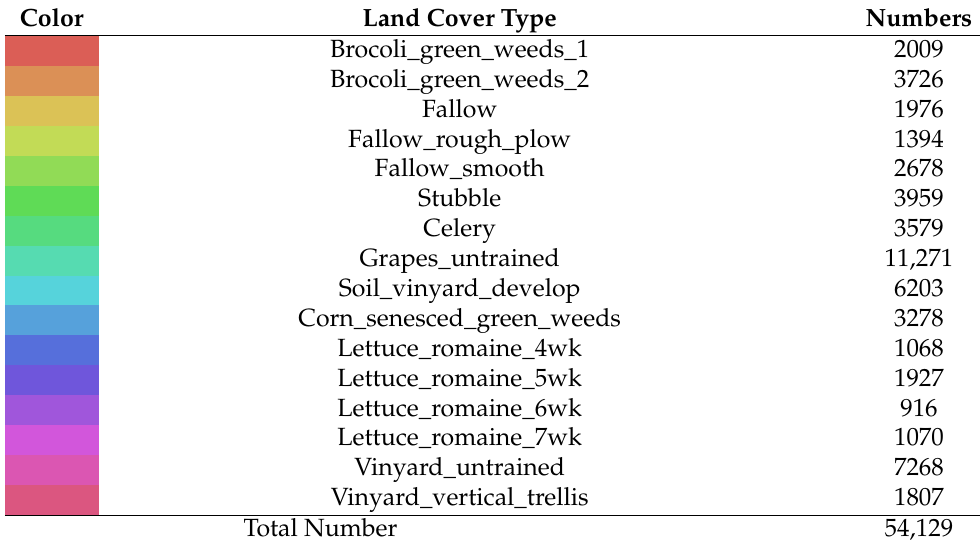
Table 2. background color and number of land cover classes on